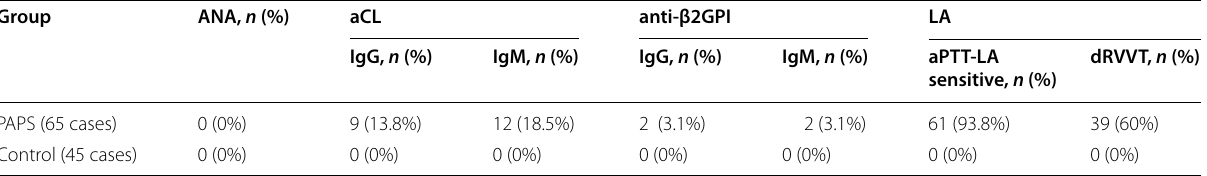
Table 2 Distribution of aPL positivity among healthy controls and patients with PAPS